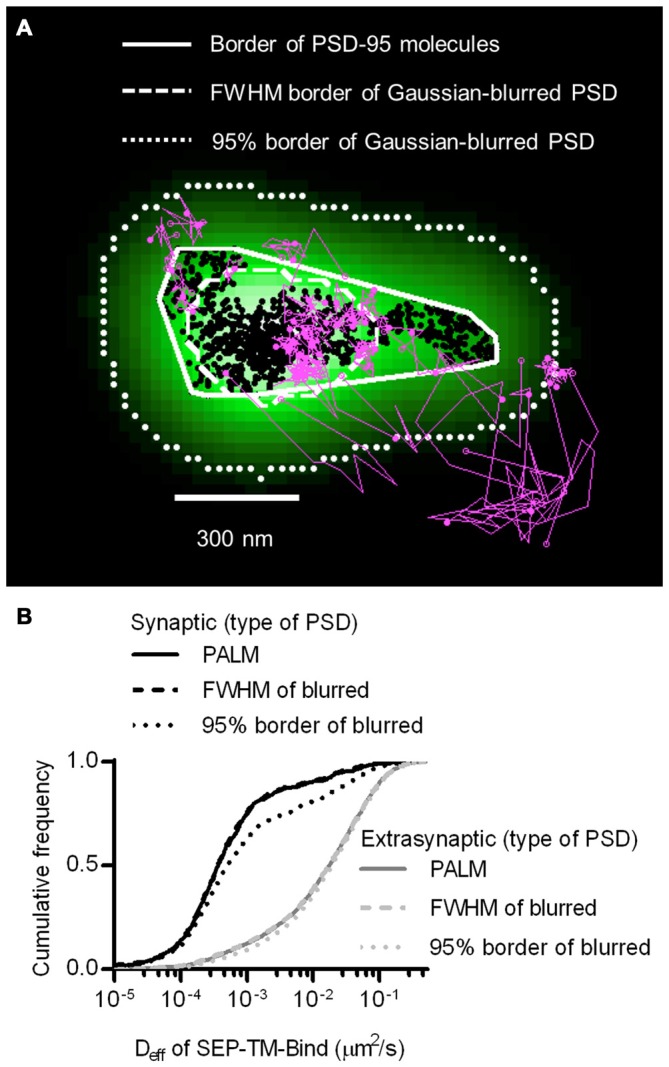
Better discrimination of postsynaptic density (PSD) border reveals strong reduction of mobility within synapses. (A) Typical tracks of the binding probe (magenta) and positions of shrPSD-95 (black circles) super-imposed. Convex hull border of PSD-95 positions (solid line), full-width half max (FWHM) border of Gaussian-blurred shrPSD-95 positions (dashed line), and full-width 5% max (95%) border (dotted lines). (B) Cumulative frequency distribution of synaptic (black lines) and extrasynaptic (gray lines) tracks segregated using the synaptic borders of PSDs determined using PALM’ed shrPSD-95 (solid lines), FWHM of Gaussian-blurred shrPSD-95 positions (dashed lines), or full-width 5% max (95% border) of the Gaussian-blurred shrPSD-95 positions (dotted lines) (n = 654 synaptic/3349 extrasynaptic tracks for PALM’ed PSDs, 658/3345 FWHM, 1197/3125 95% border; 113 PSDs, 11 cells, 3 cultures).